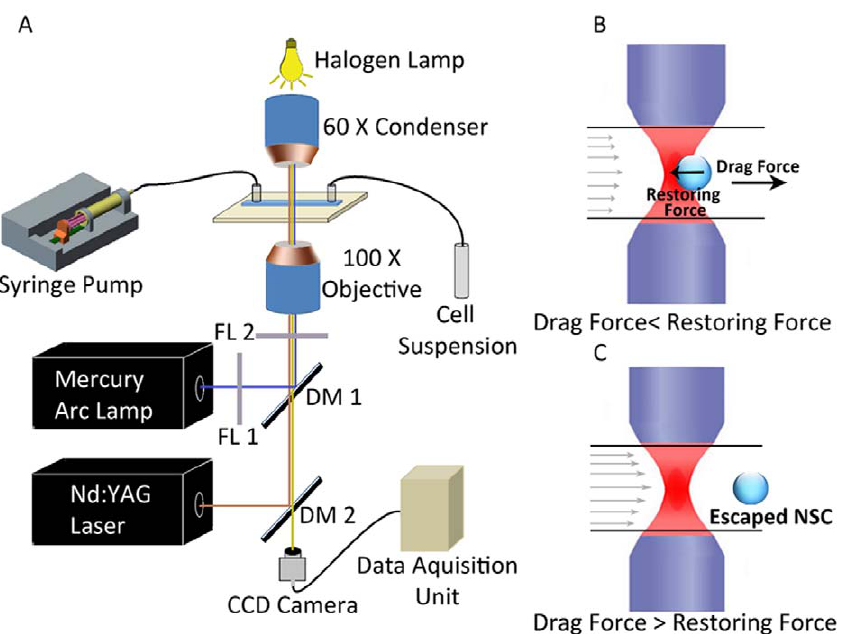
Figure 1. The experimental set-up and its principle of operation. A) Schematic diagram of the optical trap apparatus; B) Sketches depicting a neural progenitor trapped within the flow cell; and C) the principle of escape force determination.